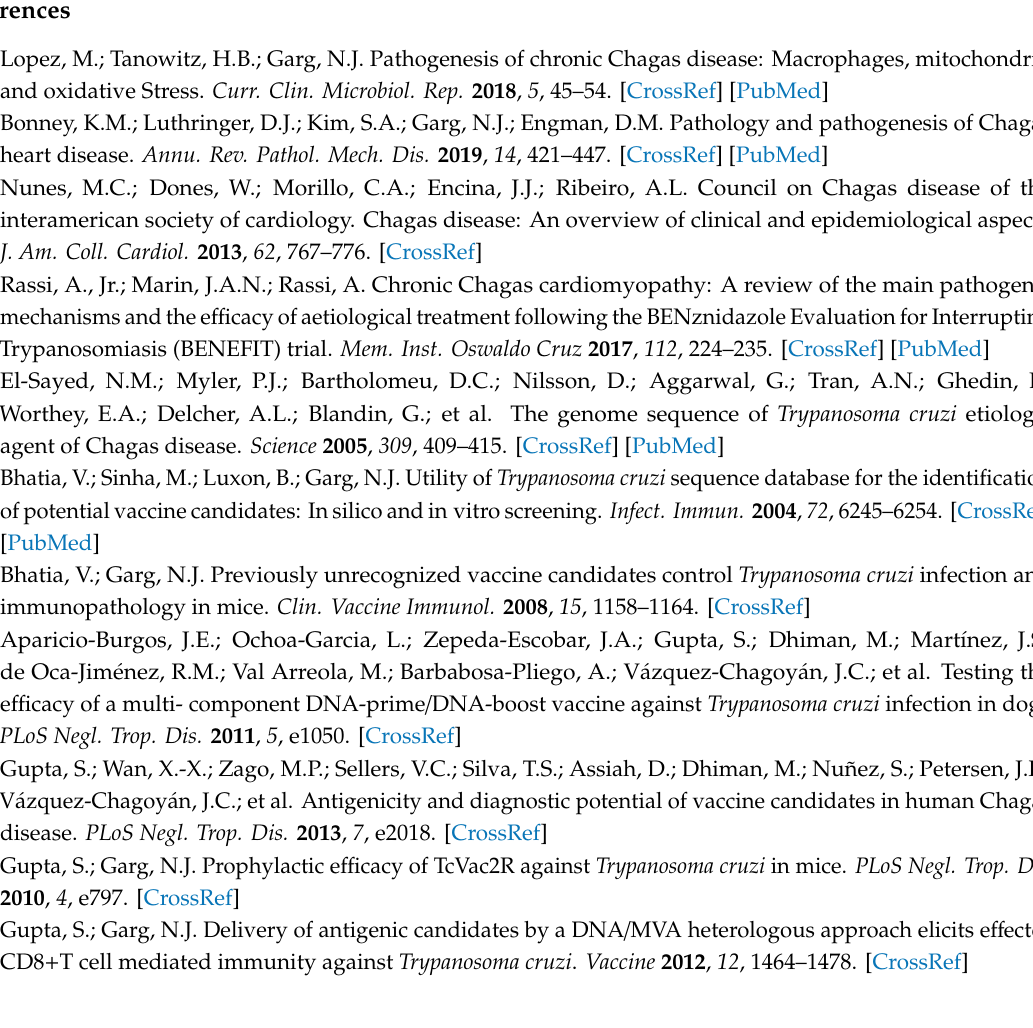
Figure S1: Schematic of experimental design and Schematic showing gating strategy for CD4 + and CD8 + T cell phenotypes, Figure S2: Splenic expression of cytokines in Chagas mice ( ± immune therapy), Figure S3: Skeletal muscle fibrosis in chronically infected mice ( ± nano immune therapy), Table S1: Oligonucleotides used in this